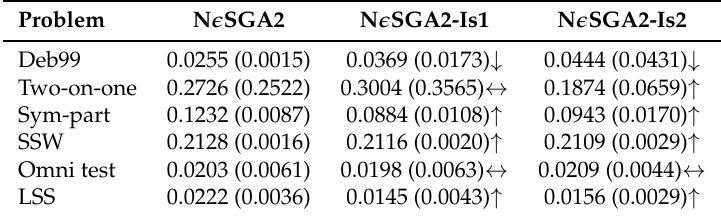
Table 5. Averaged ∆ 2 for the algorithms that use subpopulations and the base case in objective